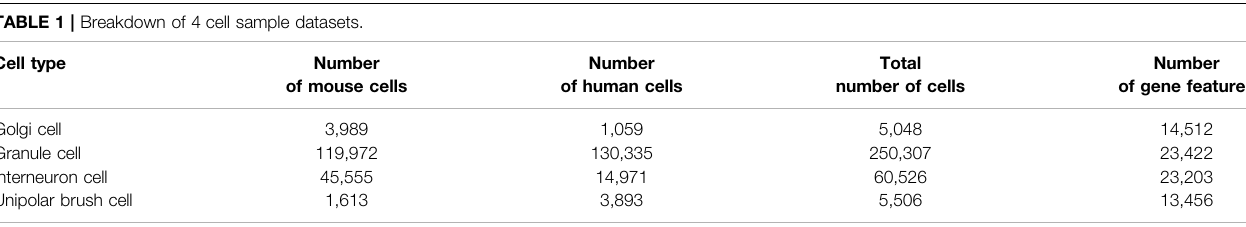
TABLE 1 | Breakdown of 4 cell sample